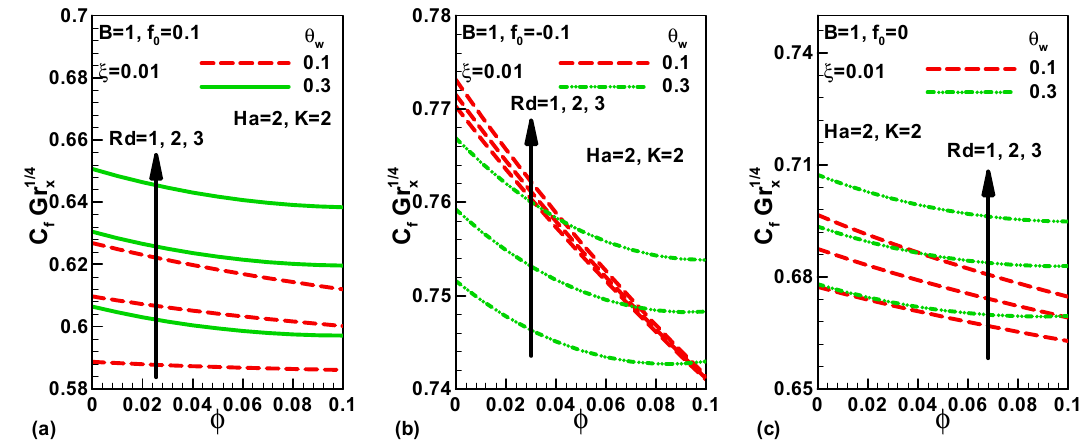
Figure 9. Variation of skin friction with solid volume fraction of nanoparticles, radiation, and wall temperature parameters along truncated cone for ( a ) suction, ( b ) injection, and ( c ) impermeable of kerosene-based magnetite nanofluid.